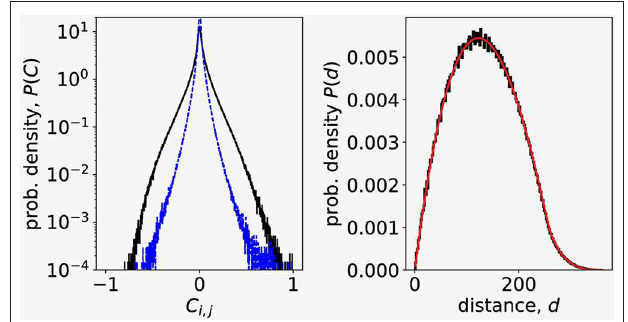
FIGURE 1 | (Left) Correlation coefficient distribution of N signals randomly chosen from experimental dataset (outer, black line). Dashed blue line is the distribution of correlations between residuals after removing the influence of the largest eigenvalue in signals. (Right) Distribution of distances between signals randomly chosen from Ca 2 + imaging data. Black line is the experimental data, thinner red line is the theoretical distribution of distances between random points in a square (Philip,